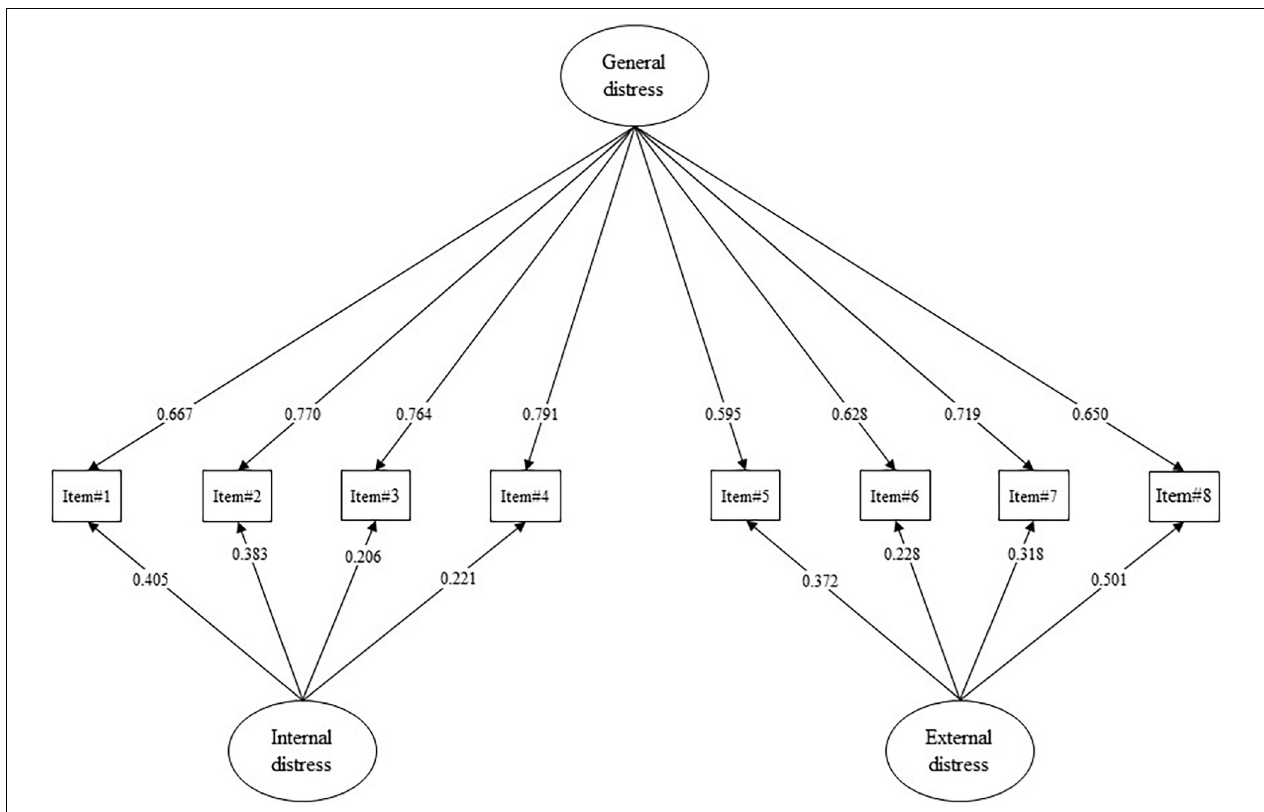
FIGURE 2 | Study 2. Confirmatory factor analysis (CFA) and factor loadings. All p -values are less than 0.001. Absolute values of standardized factor loading (| λ |) are